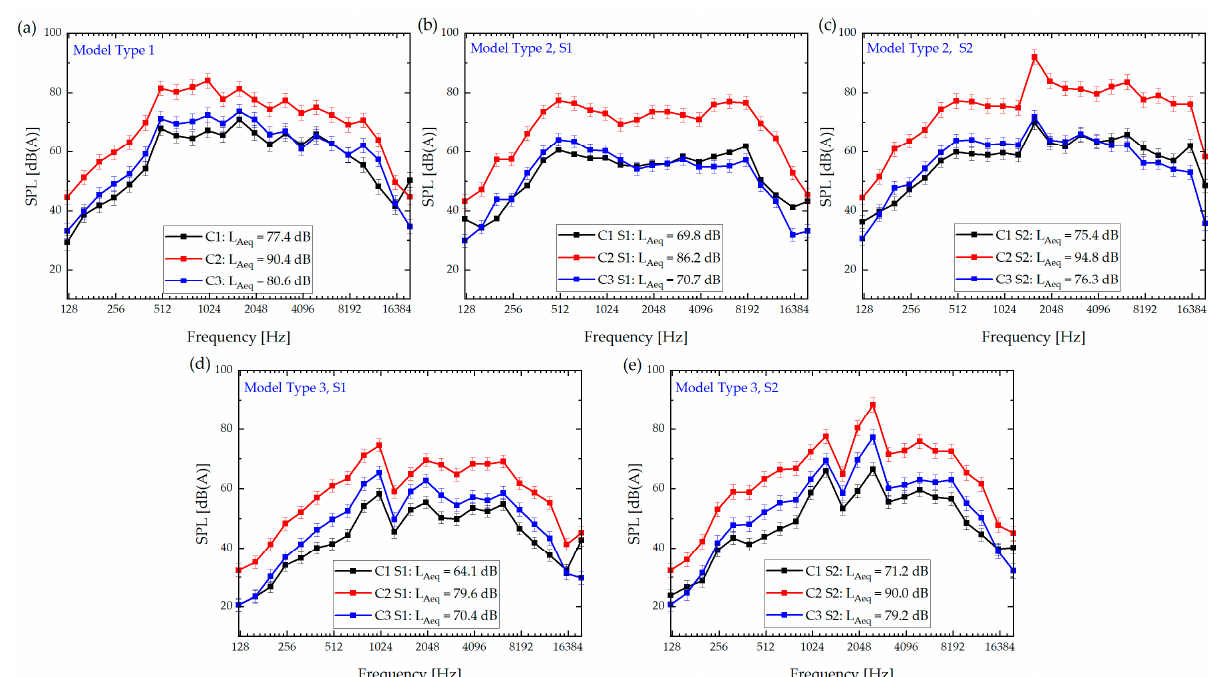
Figure 2. Sound pressure level spectra of three different vacuum cleaners: ( a ) Model type 1, ( b ) Model type 2 at minimum speed setting S1, ( c ) Model type 2 at maximum speed setting S2, ( d ) Model type 3 at minimum speed setting S1, ( e ) Model type 3 at maximum speed setting S2. All data are plotted on a log2 scale.